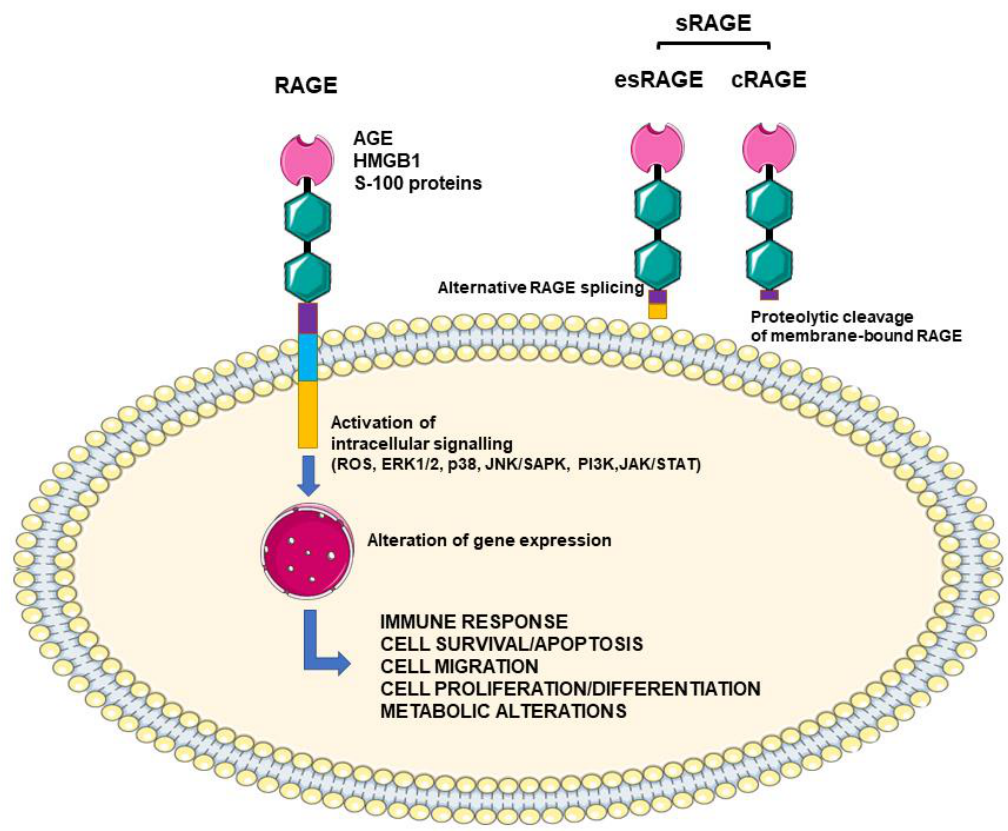
Figure 3. Membrane RAGE (receptor for advanced glycation end products) and its soluble forms esRAGE (endogenous secretory RAGE) and cRAGE (cleaved RAGE). RAGE activation promotes a pro-inflammatory response and additional changes in normal cell functions which induce organ damages. At increasing ligands, membrane RAGE expression is upregulated, and this activates a vicious circle that increases the intracellular synthesis of reactive oxygen species (ROS) and the RAGE-mediated response. Circulating sRAGE, which include esRAGE and cRAGE, can block ligand binding to RAGE, thus playing a role as a decoy receptor. HMGB1, High Mobility Group Box 1; S-100 proteins, a family of 21 proteins structurally similar to calmodulin and considered to be damage-associated molecular pattern molecules; ERK1/2, extracellular signal-regulated protein kinase 1/2; p38, p38 mitogen-activated protein kinase; JNK/SAPK, c-Jun N-terminal kinase/stress-activated protein kinase; PI3K, phosphoinositide 3-kinases; JAK/STAT, Janus kinase/signal transducers and activators of transcription; NF-kB, nuclear factor-kB.